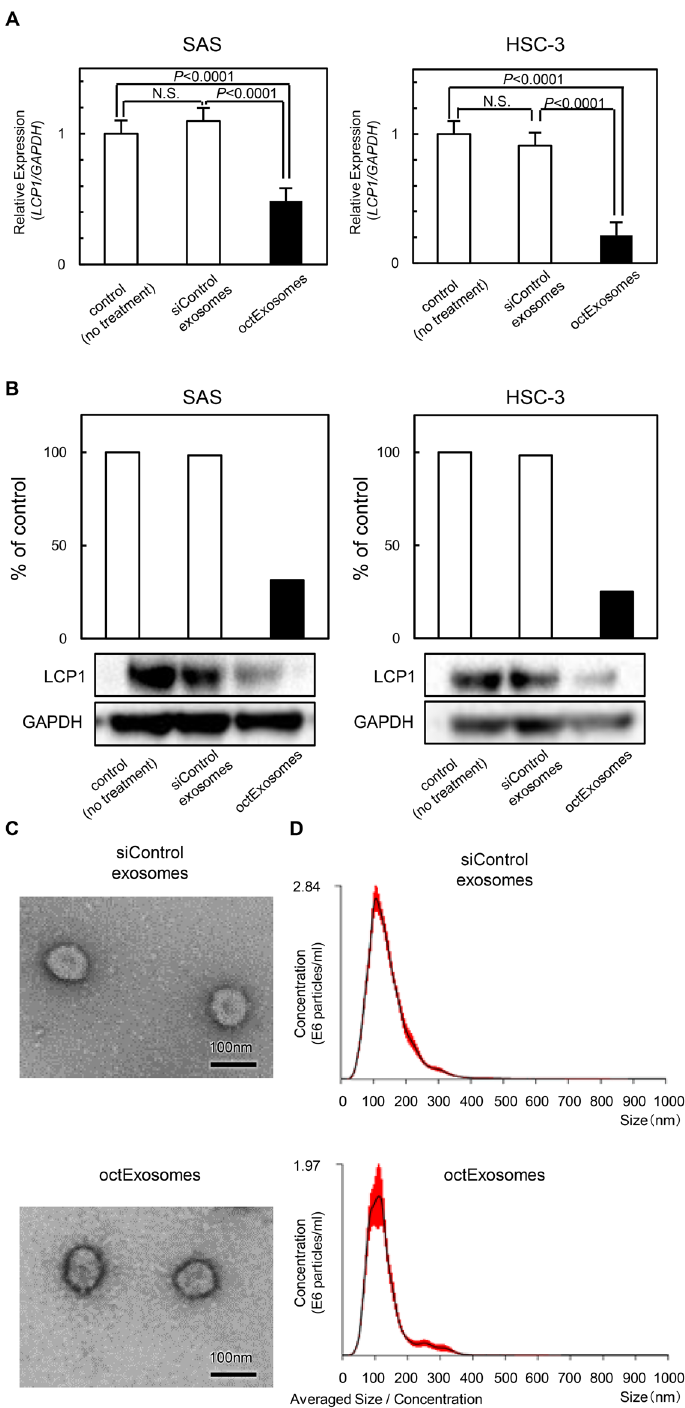
Figure 3. Influence of si LCP1 on OSCC cells treated with octExosomes or siControl exosomes. ( A ) Significant downregulation of LCP1 mRNA and ( B ) LCP1 protein levels, indicating high delivery efficiency of si LCP1 was achieved. (in A , data are presented as means ± SD, n = 3. * P < 0.05) ( C ) Electron micrograph of siControl exosomes and octExosomes. ( D ) Size distribution of siControl exosomes and octExosomes as measured by NTA peaking at 100 nm diameter. These modifications did not alter the physical properties of the modified